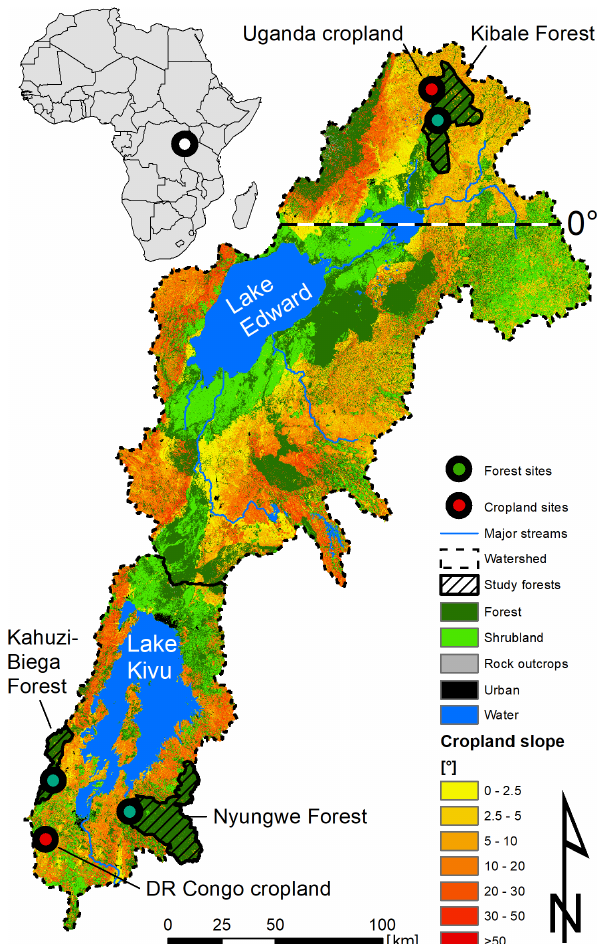
Figure 1. Study area, locations of forest and cropland sites, and topography and land use in the White Nile–Congo rift region (land- use data are based on ESA Climate Change Initiative – Land Cover project